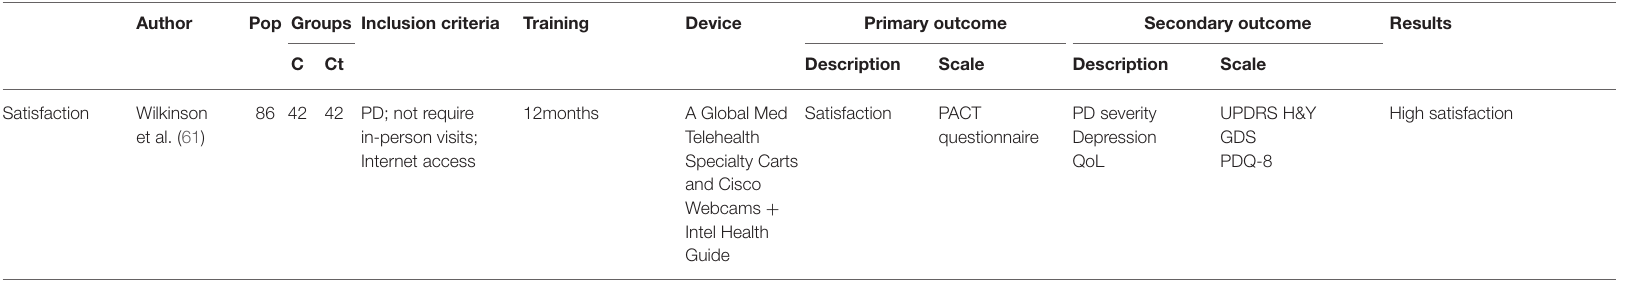
TABLE 9 | Description of the article included which have “Satisfaction” as primary